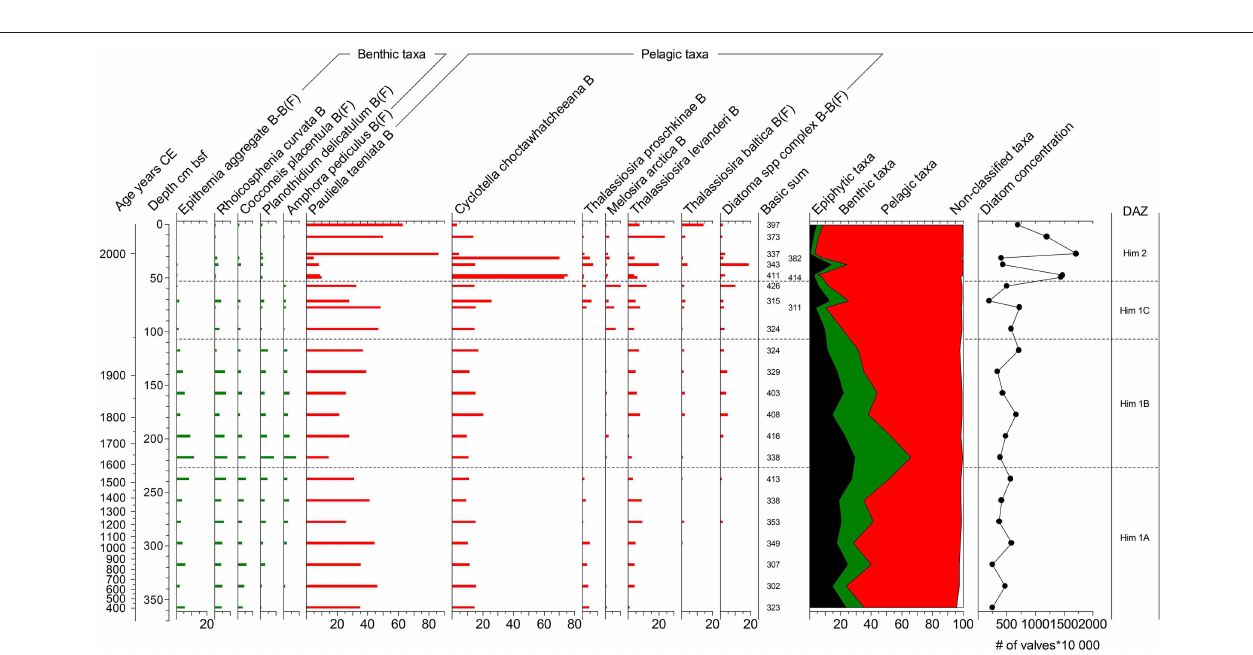
Him 2, 53–0 cm bsf, ∼ 1984–2012 CE: The topmost part